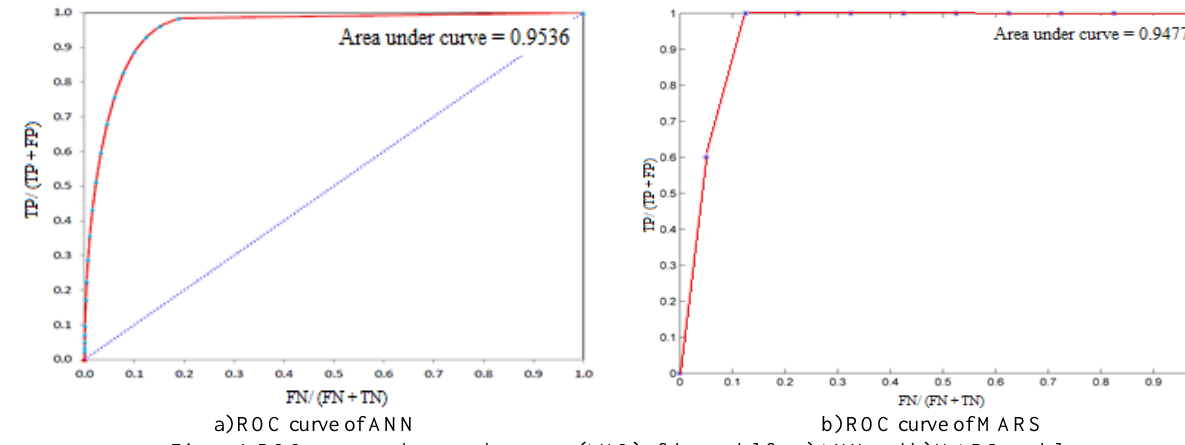
Figure 4. ROC curves and area under curves (AUC) of the model for a) ANN and b) MARS